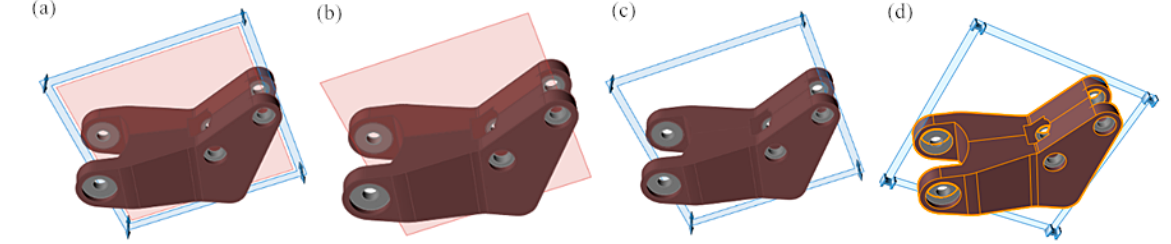
Figure 3. Shape control: ( a ) Bidirectional symmetry + draft; ( b ) Symmetry; ( c ) Bidirectional draft; and ( d ) Squeeze out.